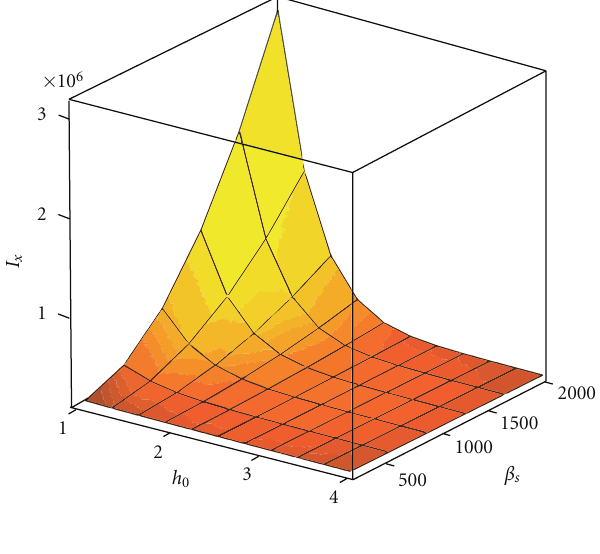
Figure 18: I x ( h 0 , a ) for β s = 500 and m = 2 × 10 − 5 .